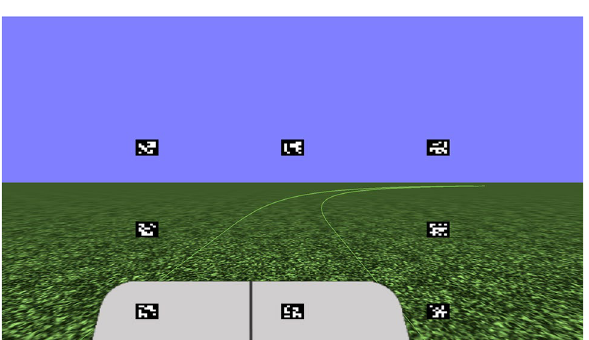
Figure 11. Simulation display. The gray zone imitates the vehicle body, and the black line in the grey zone shows the center of the vehicle. The driver position is on the right side of the